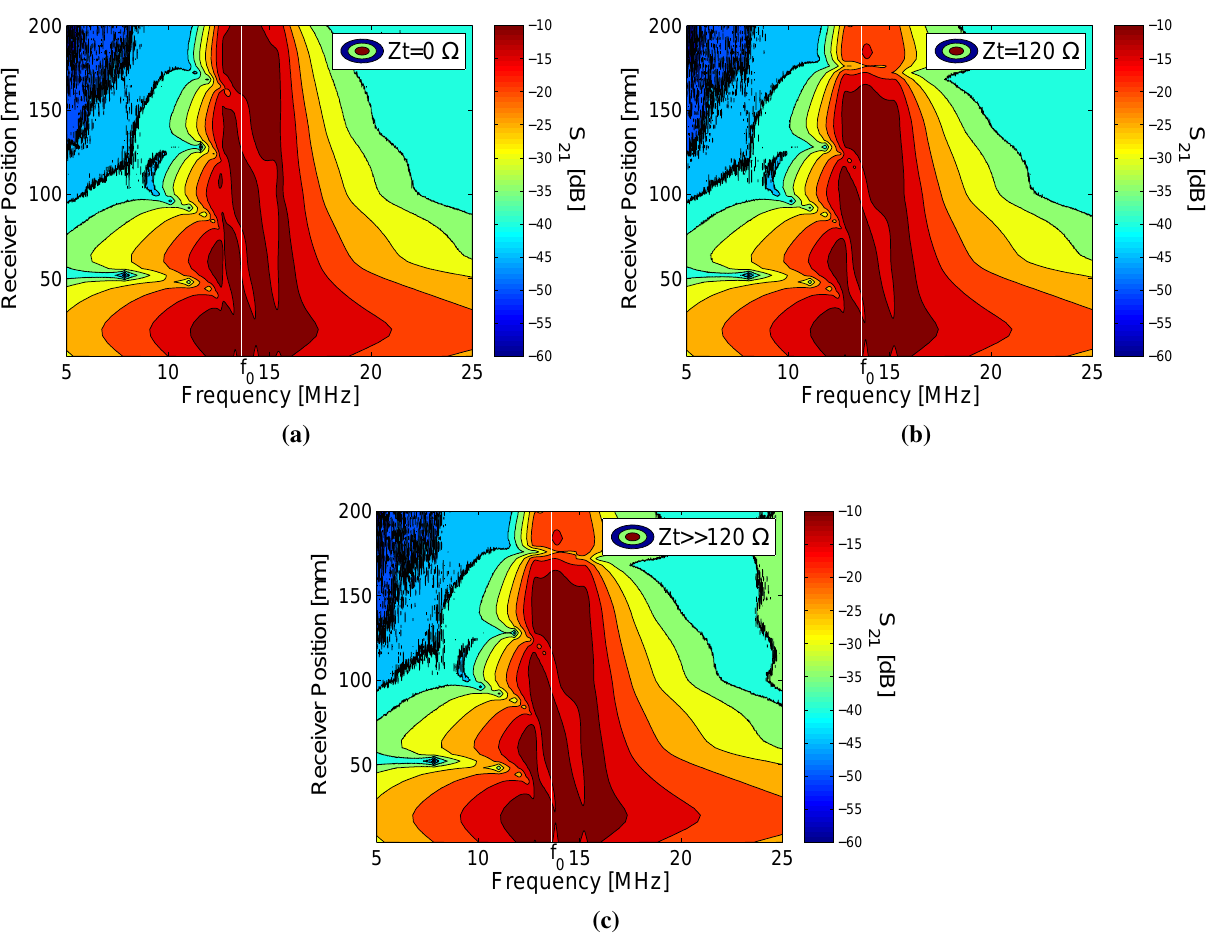
Figure 7. Measurements of S as a function of frequency and receiver position for: 21 ( a ) Z T = 0 Ω ; ( b ) Z T = 120 Ω ; and ( c ) Z T (cid:29) 120 Ω .